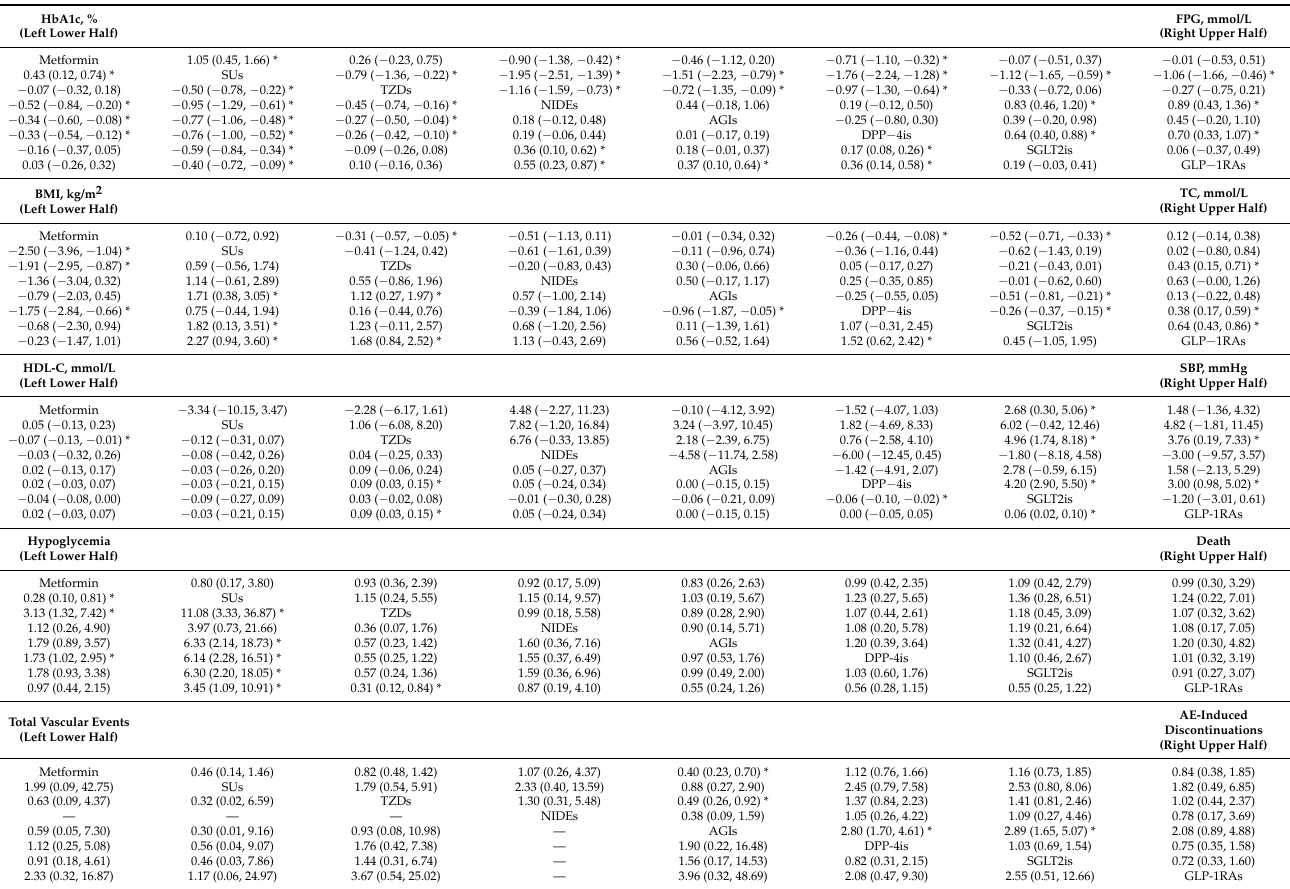
Table 2. Treatment effects of glucose-lowering drugs compared with each